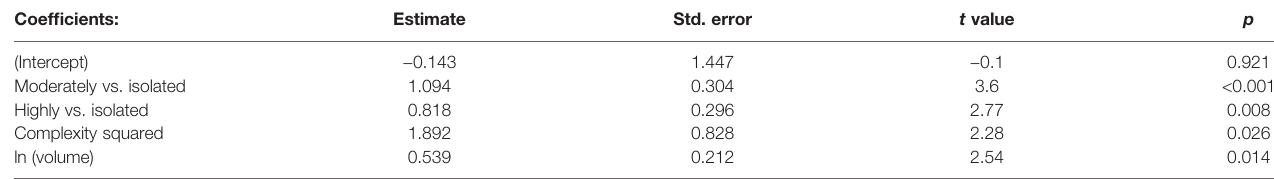
TABLE 3 | Simpli fi ed generalized linear model (ANCOVA) for faunal species richness in the rhodoliths (Isla del Coco, Costa Rica). Coef fi cients: Estimate